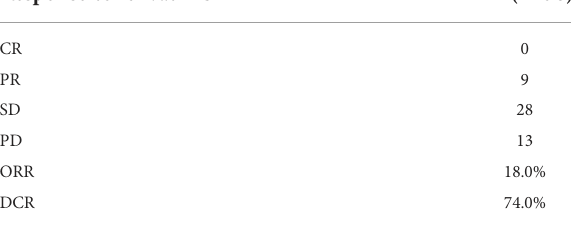
TABLE 2 ORR and DCR in the 50 patients with unresectable HCC who received lenvatinib as second-line treatment. Response to lenvatinib